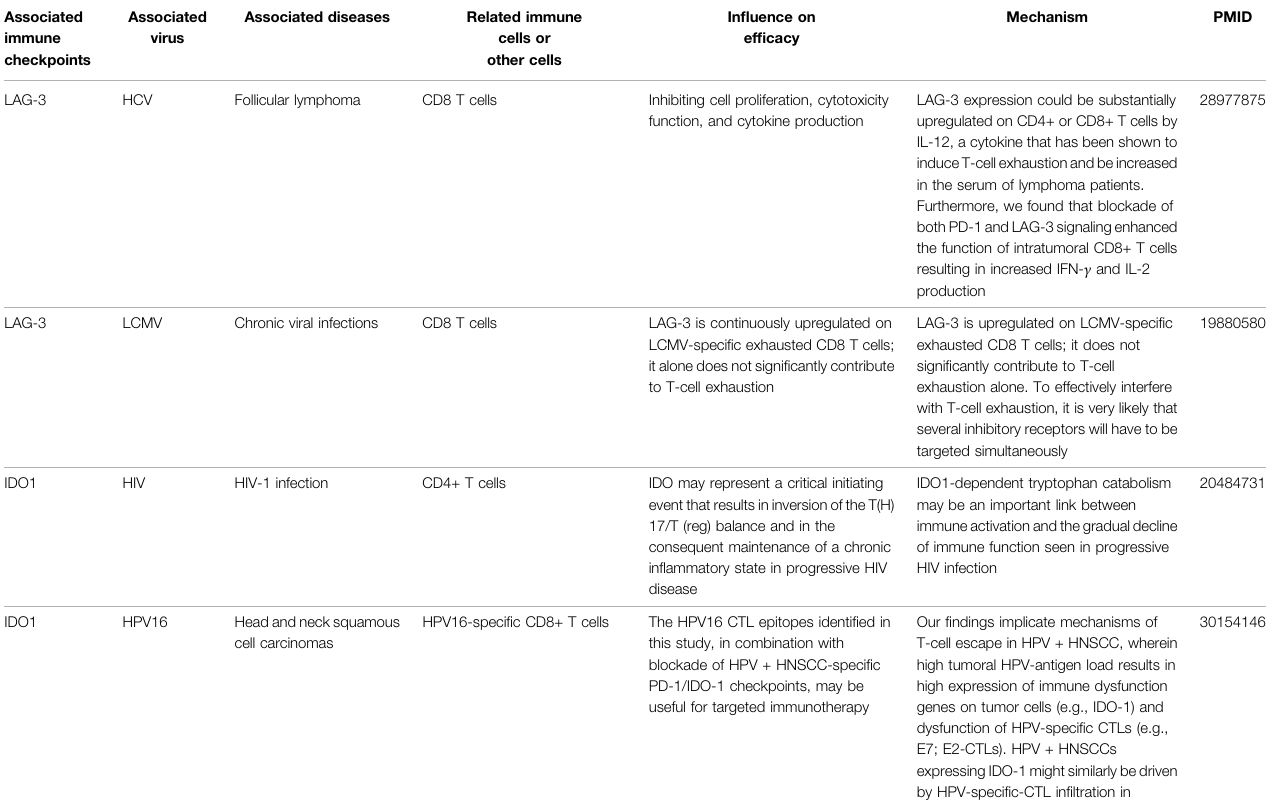
TABLE 3 | ( Continued ) The role of immune checkpoints in virus infection